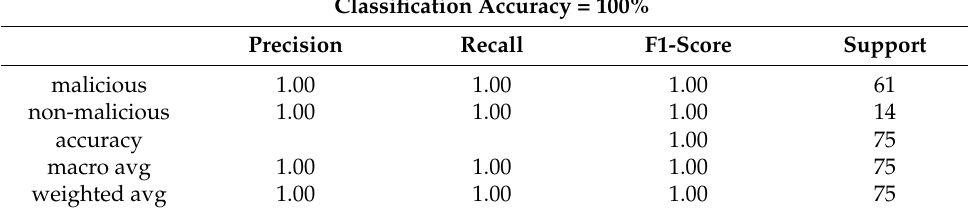
Figure A6. SGD classifier model summary with a confusion matrix. Table A6. Extra trees classifier.